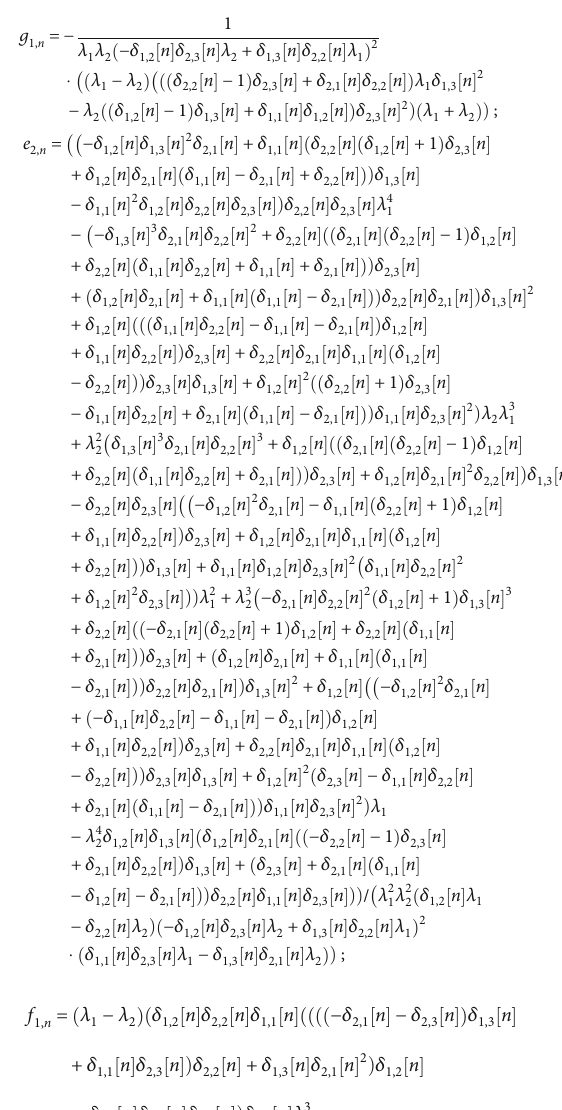
Figure 5: The evolution of solution ~ q with parameters λ 1 = 0 : 4 , λ 2 = 25 , κ 1 = 32 , and κ 2 = 0 : 8